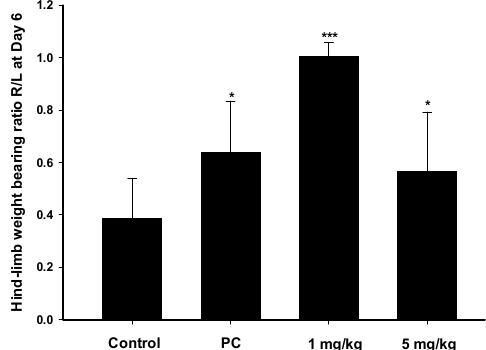
Figure 5. Distribution ratio of right and left hind-limb weight-bearing with mono-iodoacetate (MIA)-induced rat osteoarthritis on day 6. The positive control (PC) was indomethacin (10 mg/kg). * p < 0.05, *** p < 0.0005 compared to the control group.